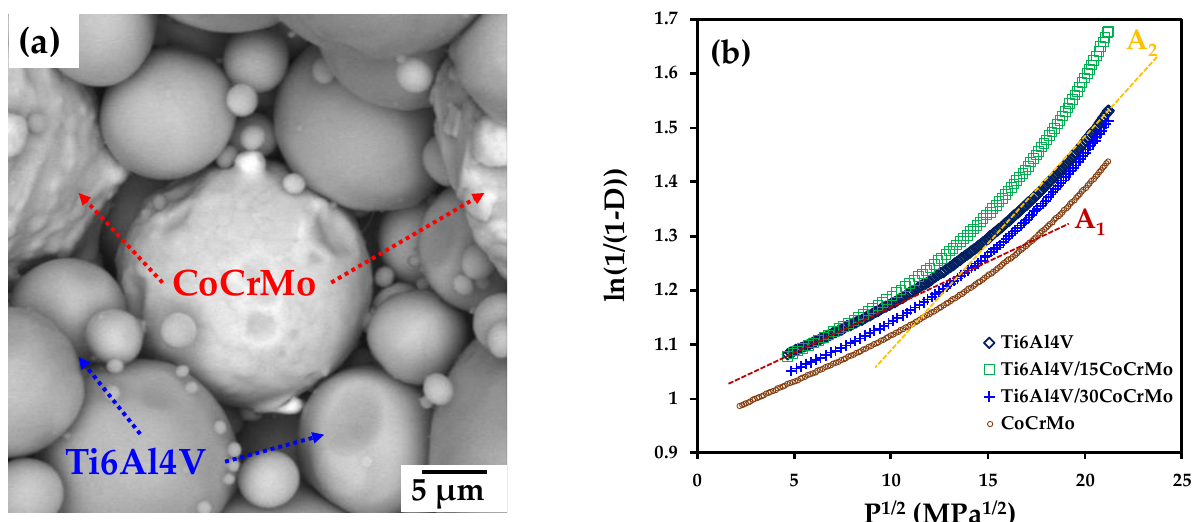
Figure 5. ( a ) SEM micrograph of fractured Ti6Al4V/15CoCrMo sample after compaction and ( b ) Panelli–Filho model for compressibility under cold compaction.